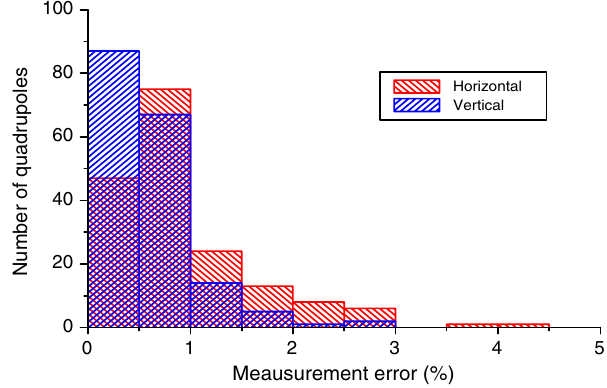
FIG. 2. Statistical error in the average beta measurement of Fig. 1: red bars for the horizontal plane, blue for the vertical. The statistical error is evaluated from several tune measurements along increasing quadrupole